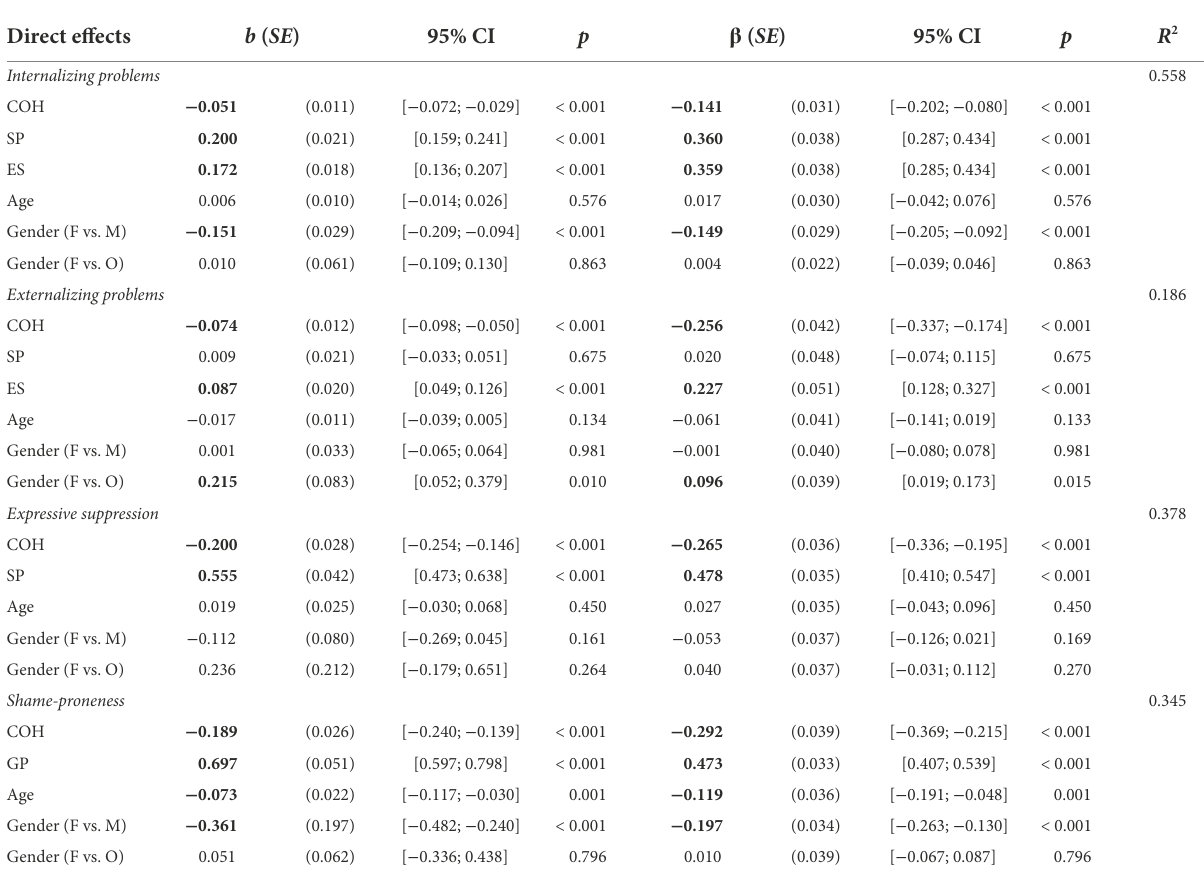
TABLE 3 Direct effects of the path